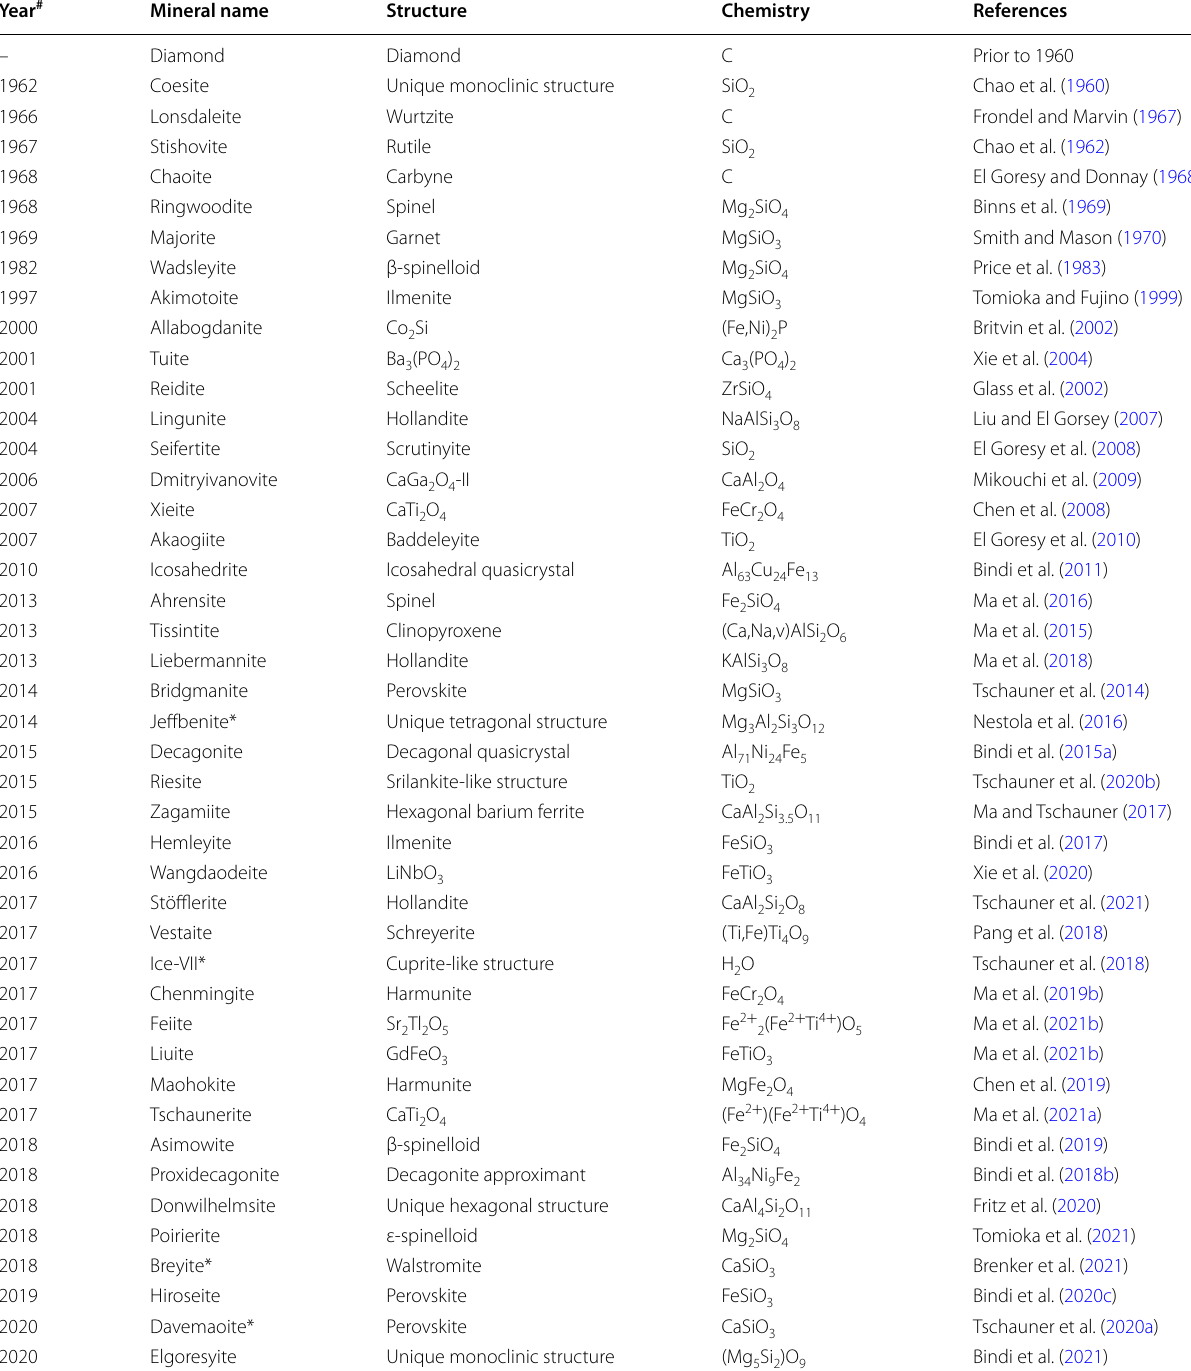
Table 1 Inventory of high-pressure